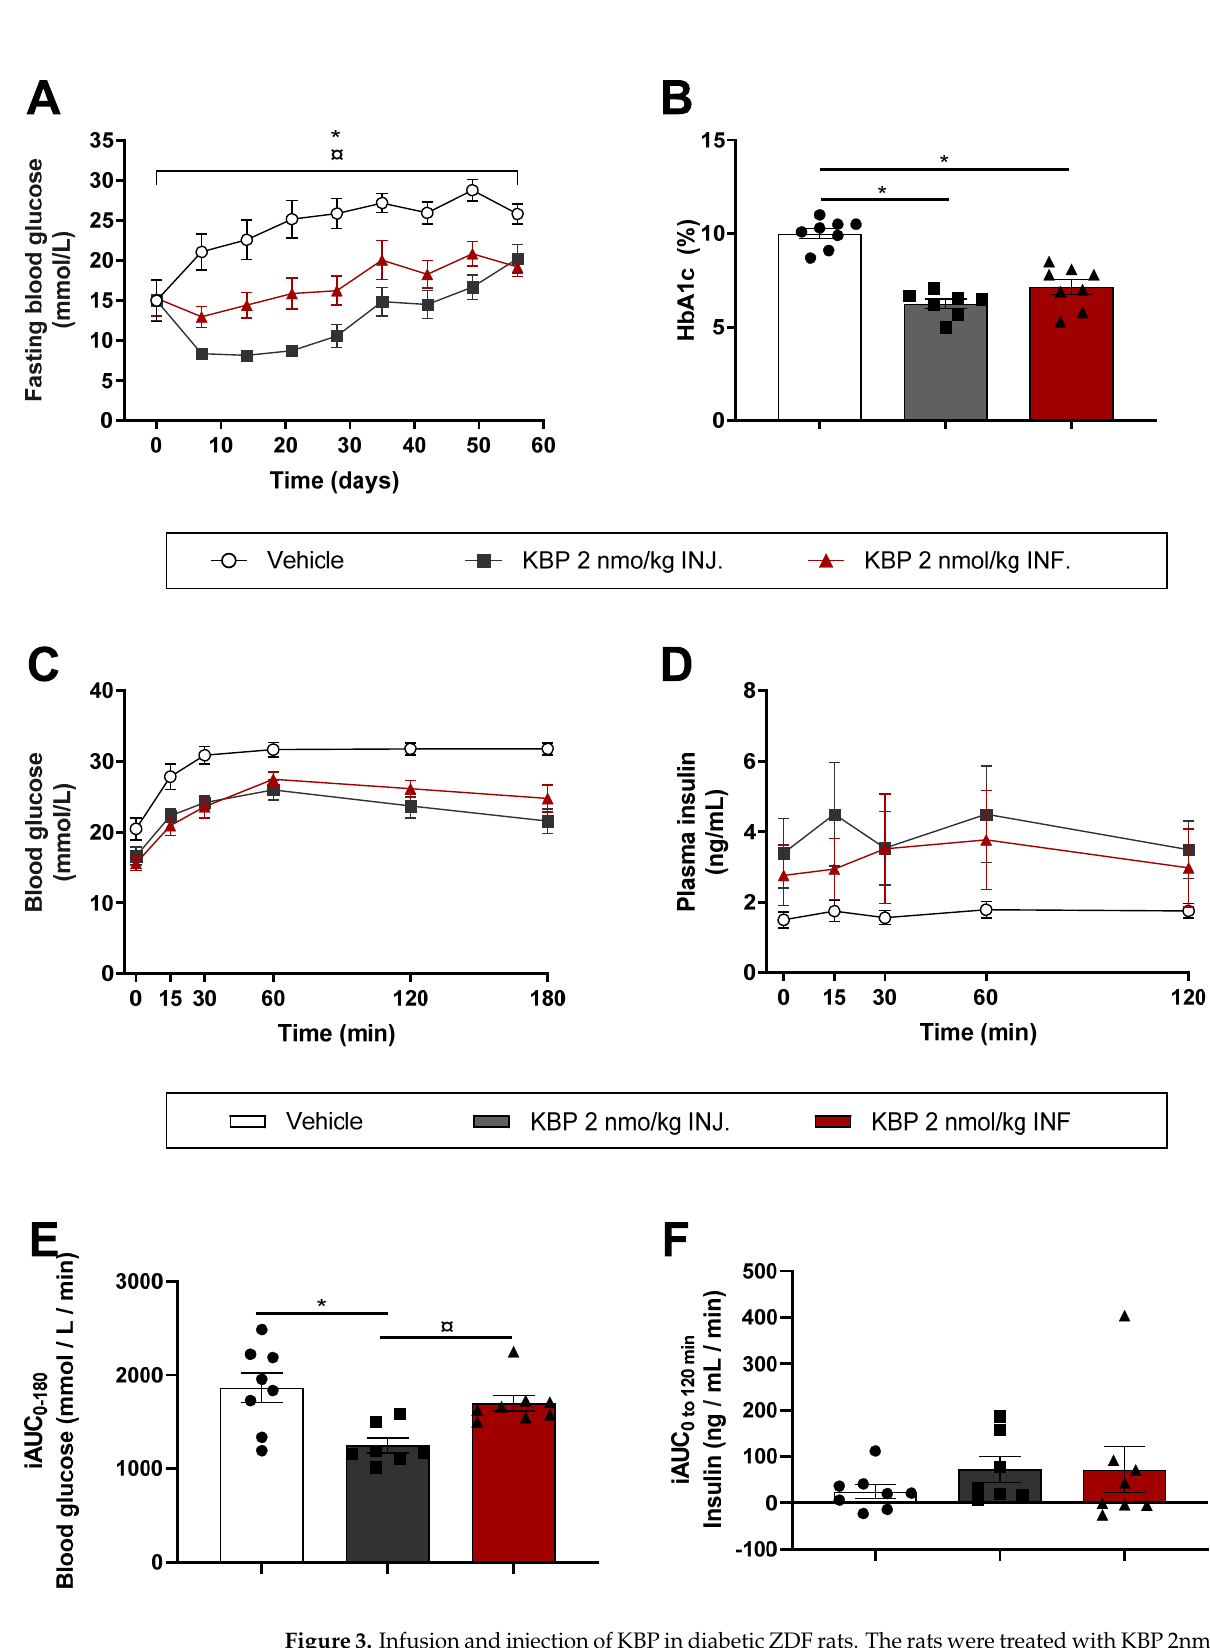
Figure 3. Infusion and injection of KBP in diabetic ZDF rats. The rats were treated with KBP 2nmol/kg delivered by s.c. injection (INJ) or continuous infusion (INF). ( A ) Fasting (6 h) blood glucose was measured weekly, ( B ) and HbA1c at the study end. After 7.5 weeks, the rats were overnight fasted (11 h) before an OGTT. The rats were dosed 24 h prior to the glucose challenge. ( C ) Blood glucose